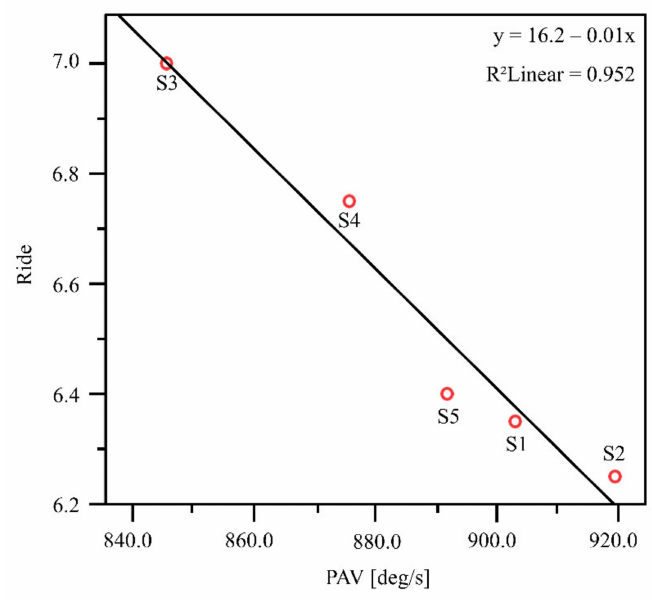
Figure 5. Correlation between PAV and ‘ride’. Analysis was based on the calculation of the median over the 20 participants for PAV and ‘ride’ for each of the five shoe